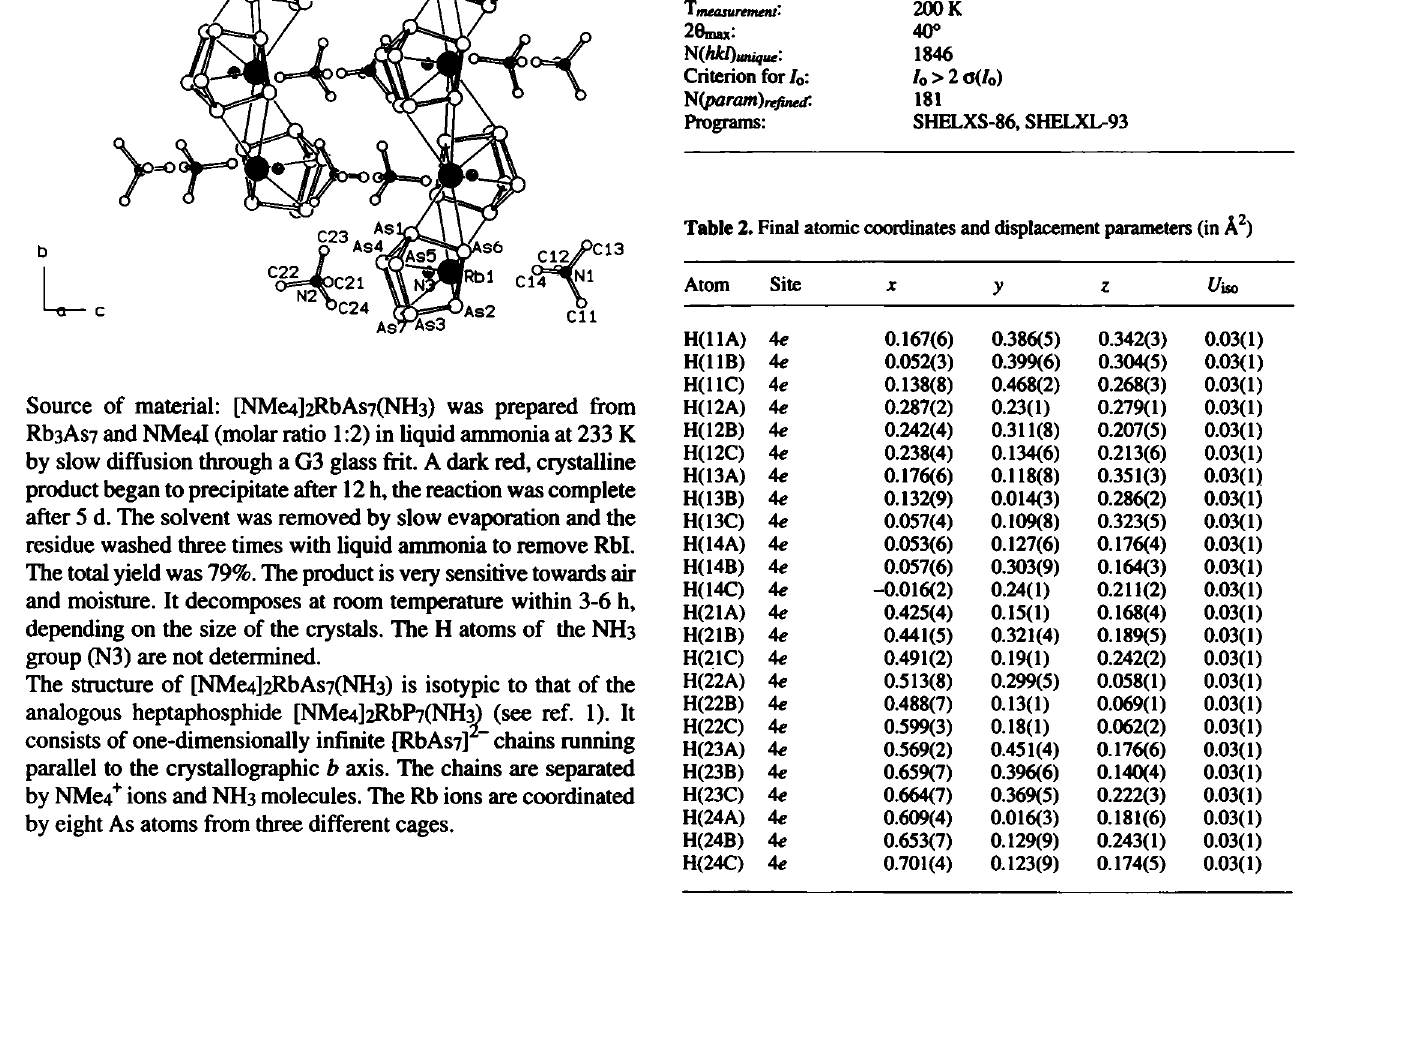
Table 1. Parameters used for the X-ray data collection Crystal: